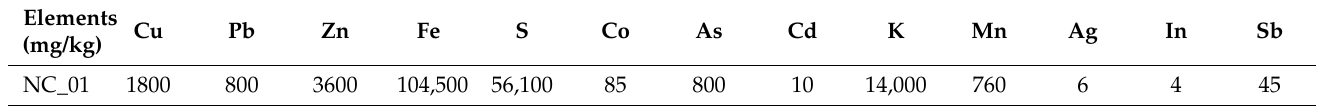
Table 1. Chemical composition of the Neves Corvo waste rock